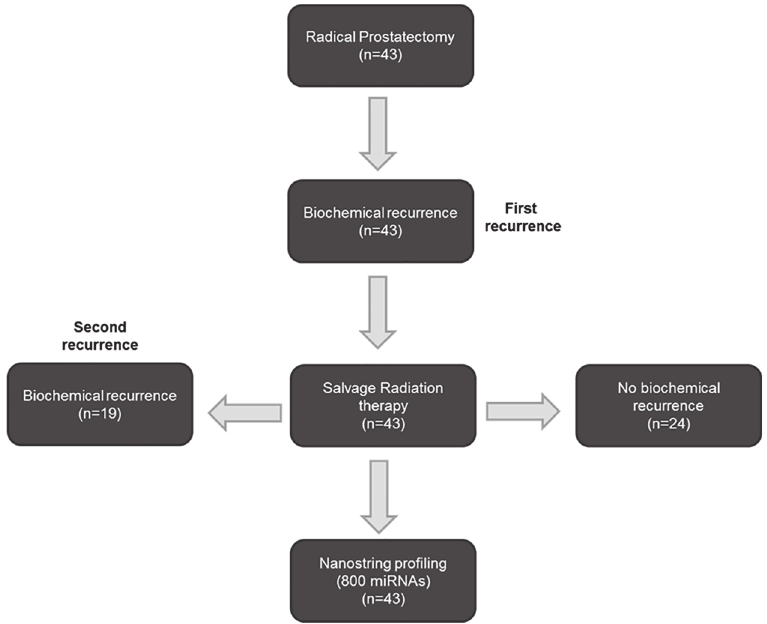
Fig 1. Study design. All patients underwent radical prostatectomy and salvage radiation therapy following biochemical recurrence. Tissue isolated at the time of radical prostatectomy (n = 43) was used for miRNA